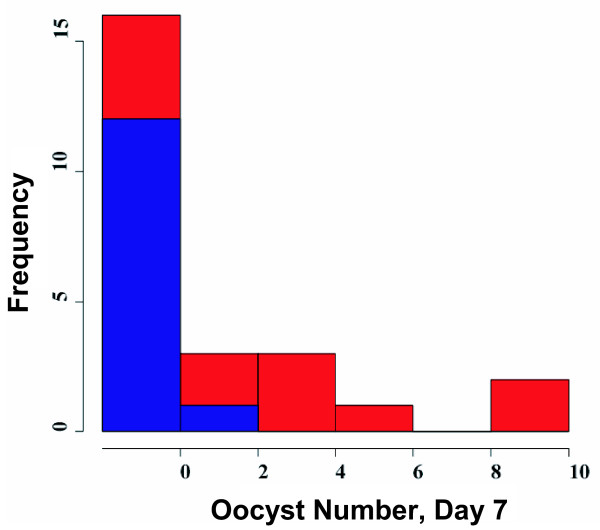
Oocyst distribution and allele frequency at microsatellite marker H796. Four alleles are segregating at H796, but only two are informative for infection outcome. Allele 82 (blue) is linked to low oocyst number (average oocyst number 0.08) and allele 84 (red) is linked to high oocyst number (average oocyst number 2.9). Similar histograms can be drawn for the other loci yielding significant linkage with infection outcome.